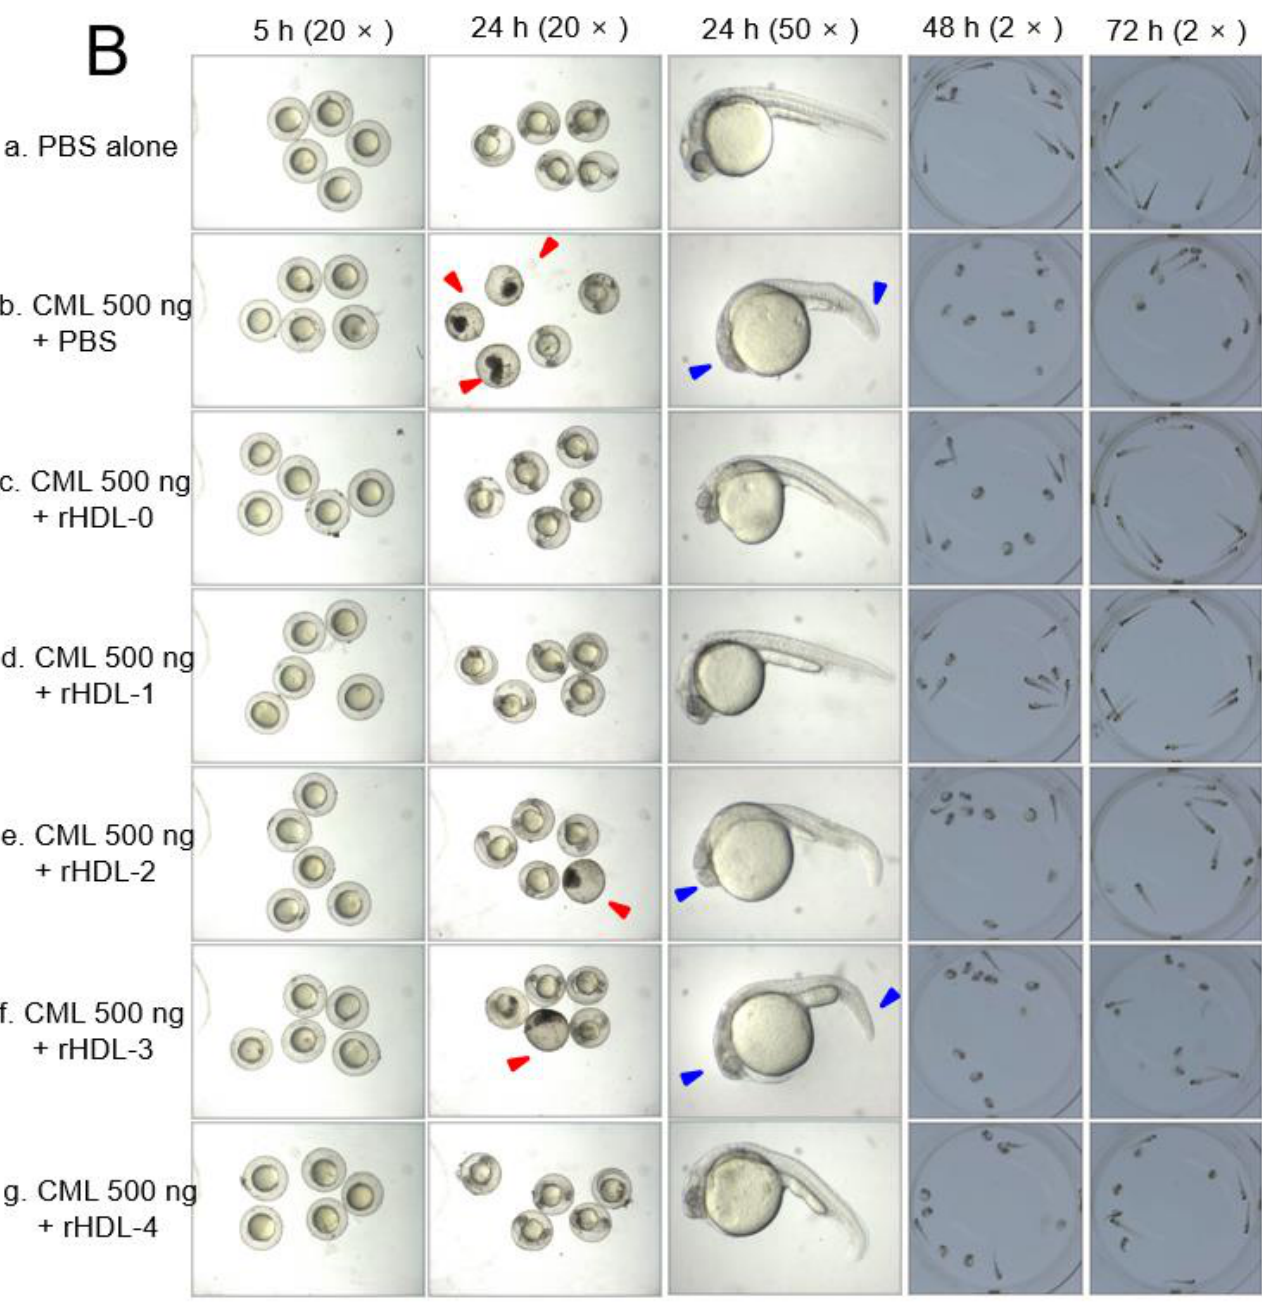
Figure 6. Comparison of survivability and embryo development among rHDLs containing each policosanol in the presence of carboxymethyllysine (CML). ( A ) Survivability of embryos during 24 h post-injection of each rHDL. * p < 0.05 vs. rHDL-3; ** p < 0.01 vs. rHDL-0 or rHDL-2, or rHDL-4; *** p < 0.001 vs. rHDL-1. Embryo numbers were adjusted from three independent experiments. Statistical differences of multiple groups were compared using a one-way analysis of variance (ANOVA). ( B ) Developmental morphology of the embryo at 5 h, 24 h, 48 h, 72 h, and 96 h post- injection. The red arrowheads indicate defected development and death of embryos in the CML alone group (photo b), CML+rHDL-2 (photo e), and CML+rHDL-3 (photo f). The blue arrowhead indicates the slowest developmental speed in eye pigmentation and tail elongation in the CML alone group (photo b) and CML + rHDL-3 (photo f) at 24 h post injection. a. PBS-alone injected; b. CML + PBS injected c. CML + rHDL-0 injected; d. CML + rHDL-1 injected; e. CML + rHDL-2 injected; f. CML + rHDL-3 injected; g. CML + rHDL-4 injected.